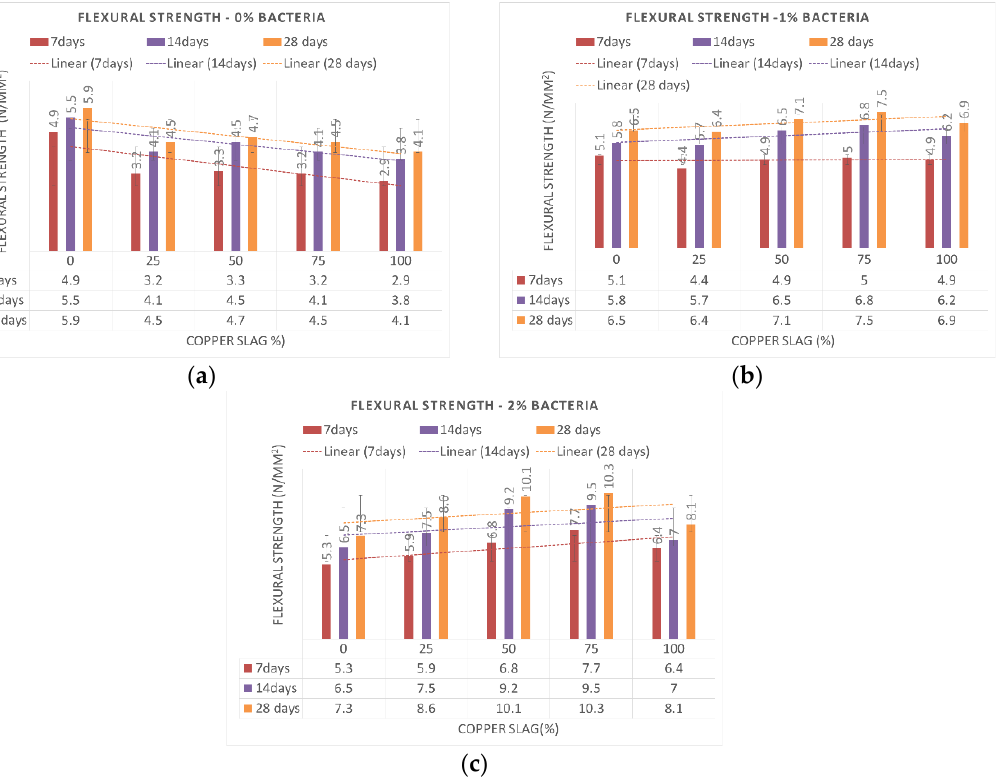
Figure 12. Flexural strength of copper slag concrete with micro-organisms. ( a ) 0% bacteria. ( b ) 1% bacteria. ( c ) 2% bacteria.